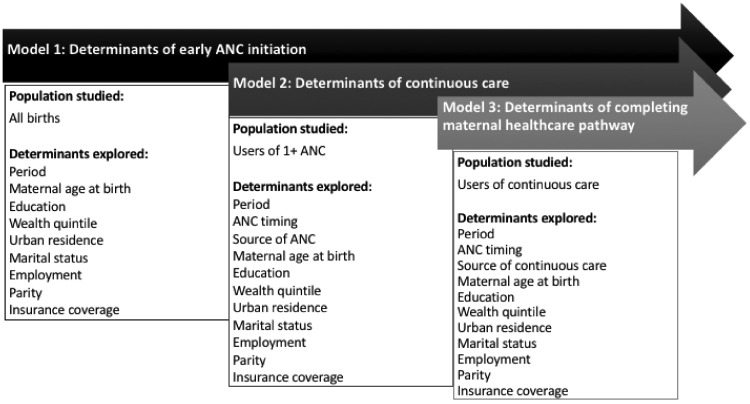
Diagram of three-step logistic analysis approach.